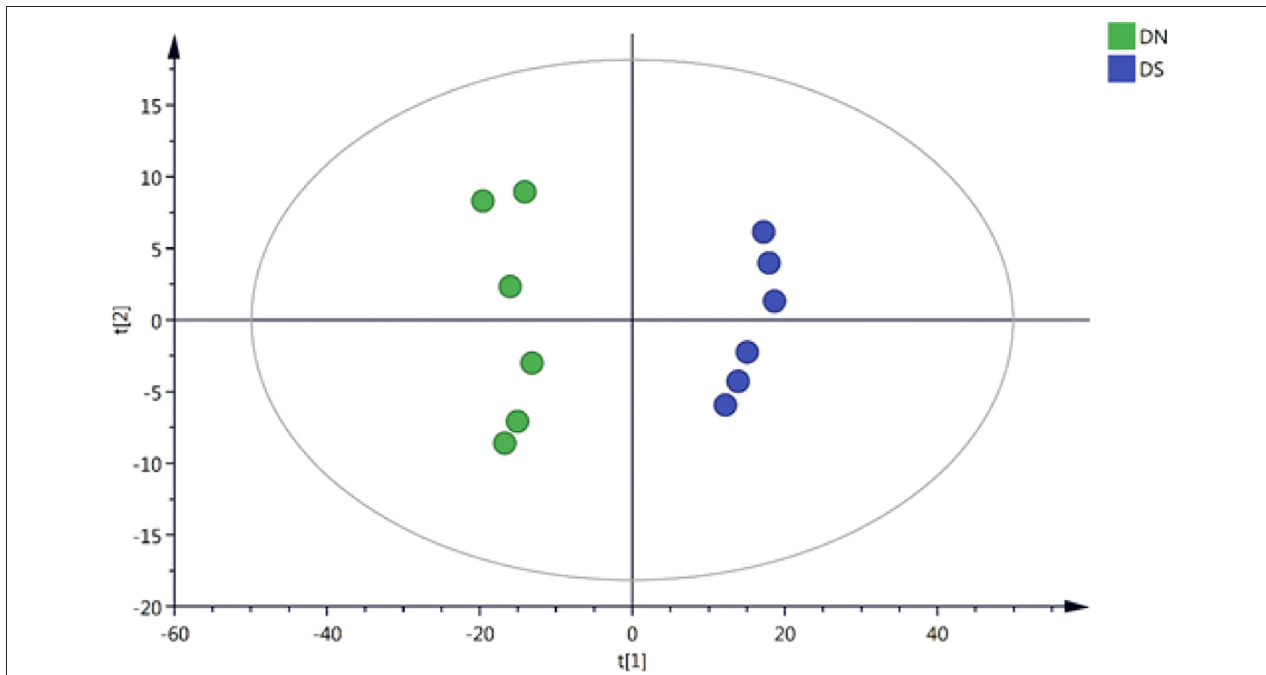
FIGURE 1 | Principal component analysis (PCA) score plots for two samples of DN and DS. DN is Dongxiang wild rice (DXWR) without salt treatment and DS is DXWR under